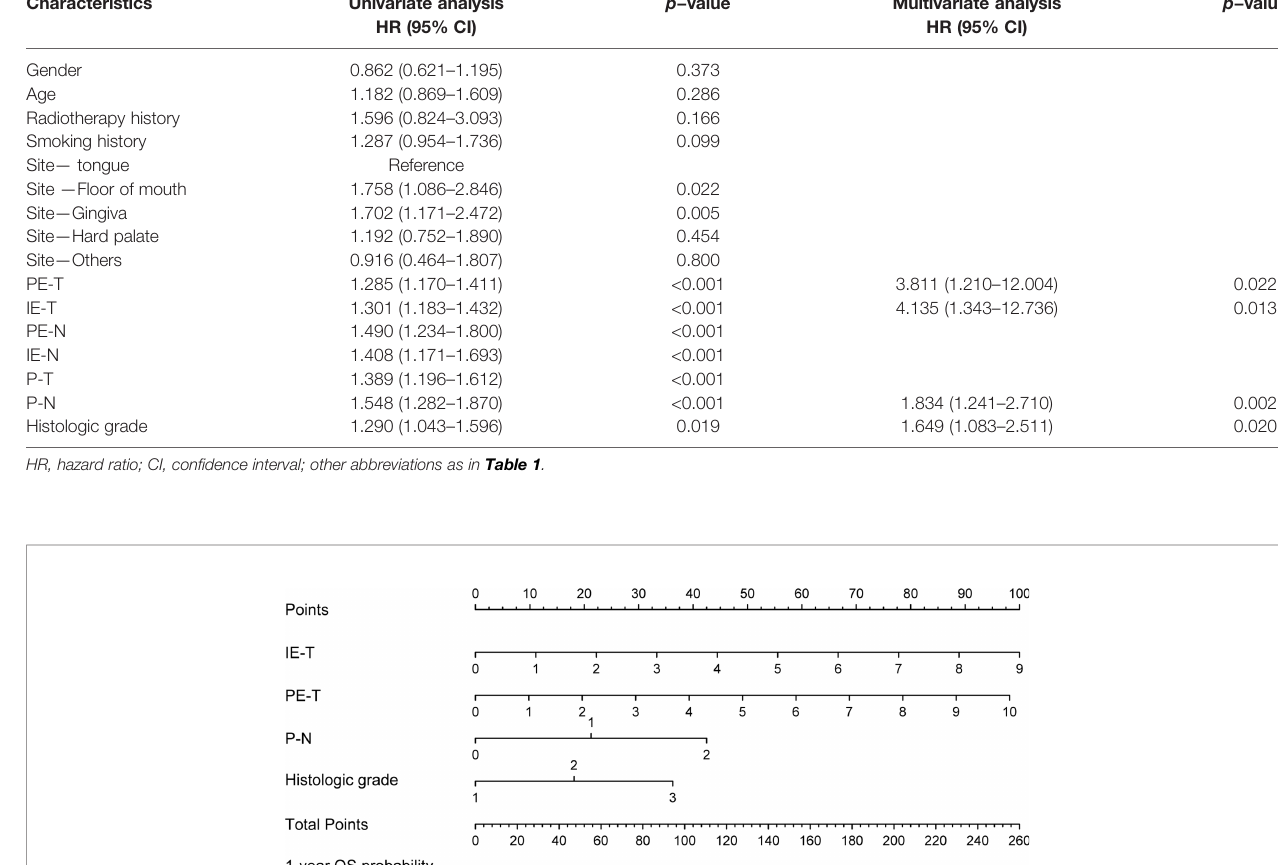
TABLE 2 | Univariate and multivariate Cox analysis for the clinical-pathological model. Characteristics